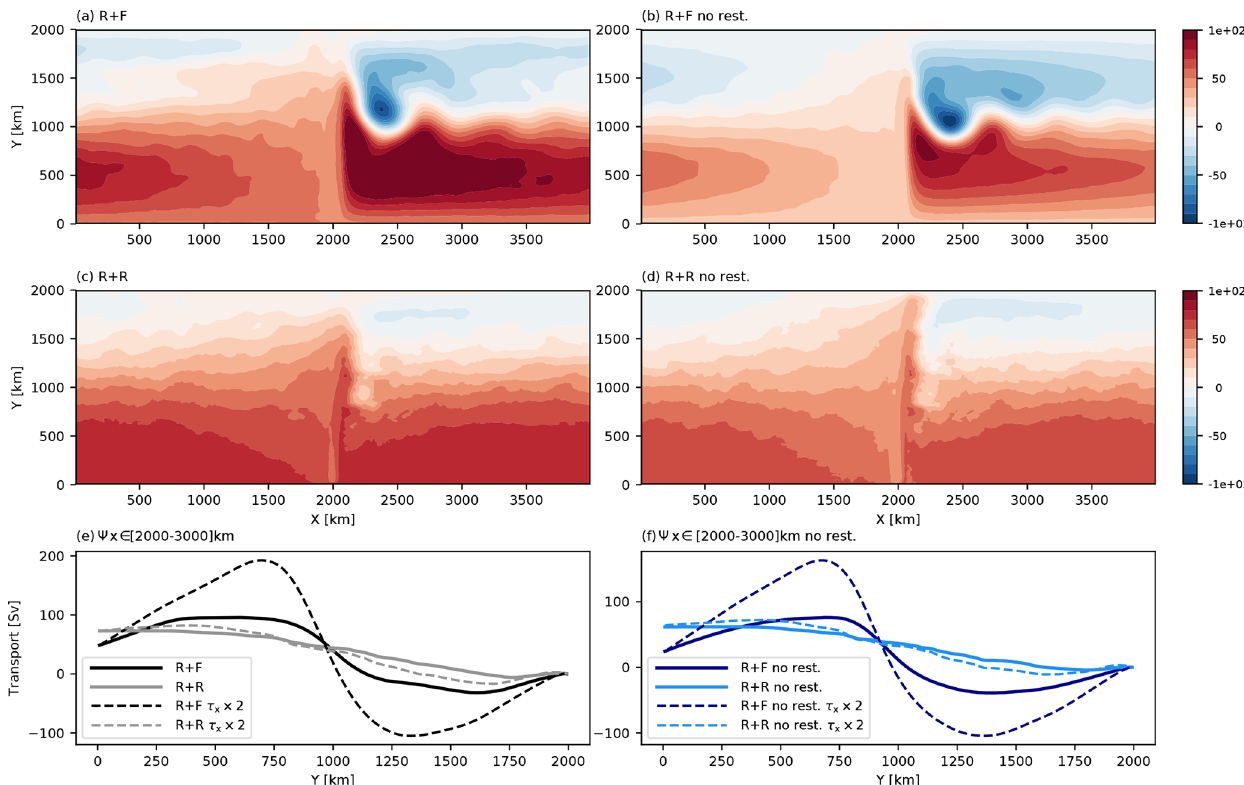
Figure 9. Barotropic streamfunction (Sv) for (a) R + F, (b) R + R, (c) R + Fnr and (d) R + Rnr. Transport averaged between x = 2000 and 3000km for the set of reference simulation (bold lines) and simulations with maximum wind stress increased 2-fold, with (e) restoring and (f) without